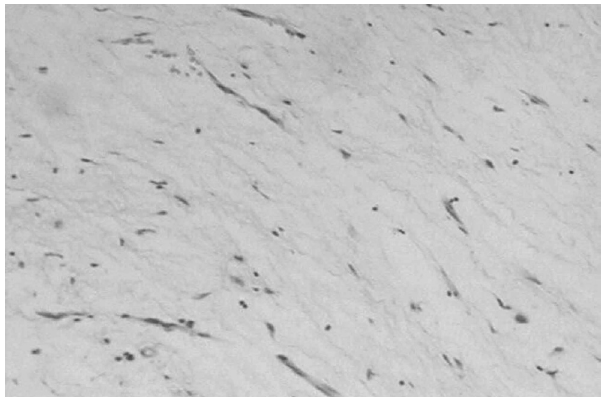
Figure 5 - Photomicrograph showing rounded, stellate and spindle-shaped mesenchymal cells arranged in abundant loose myxoid stroma with few